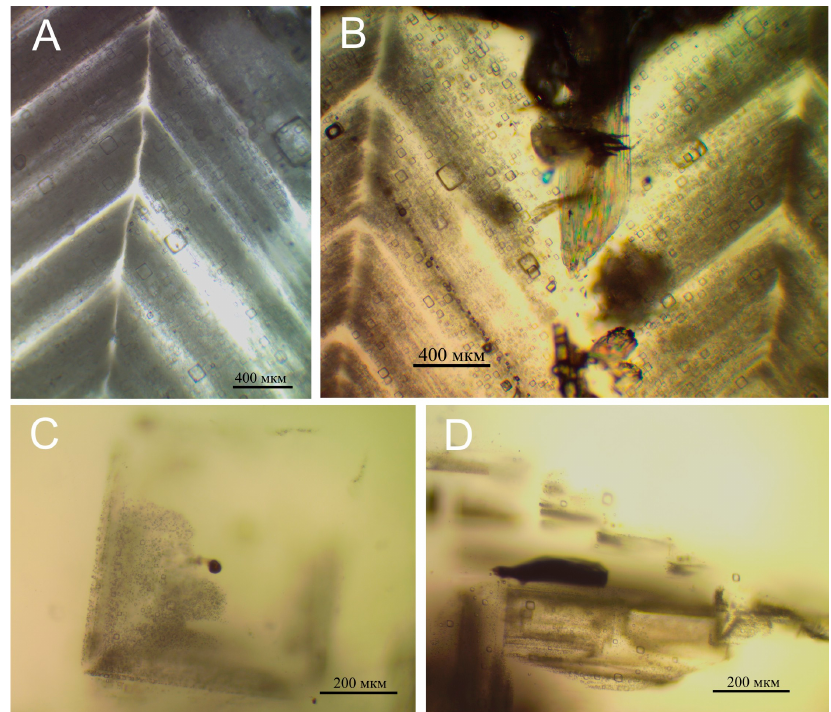
Figure 3. Sedimentary textures of halite from Tuz Gölü Basin. ( A ) Chevron: sample No. 7; ( B ) Chevron: sample No. 2; ( C ) Cumulate: sample No. 13; ( D ) Cumulate: sample No. 5; For sample location, see Figure 2 and Tables 1–2.